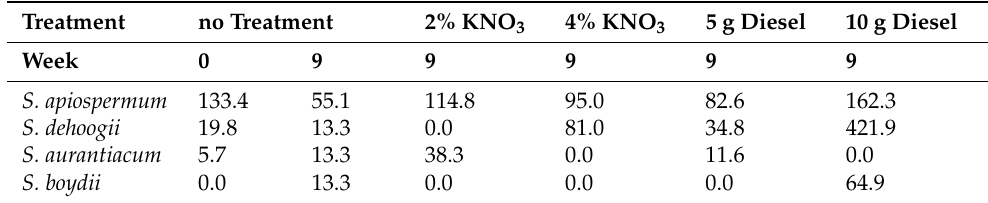
Table 3. CFU values of Scedosporium species per gram soil (dw) after 0 and 9 weeks of incubation in (un)treated pots at 25 °C. A pooled sampling was used for the determination of CFU of week 0.